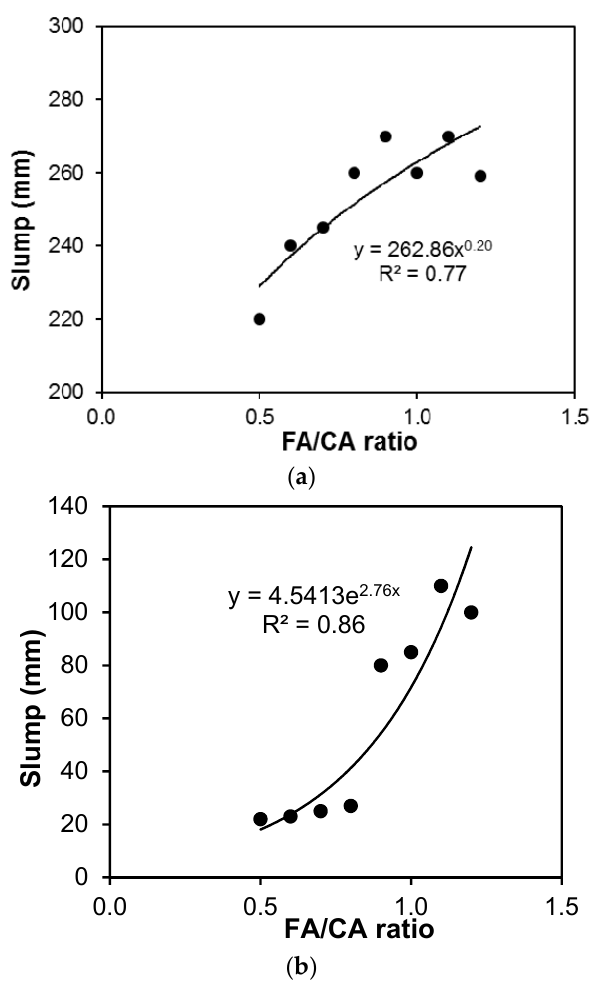
Figure 4. Slump vs. FA / CA ratio for concrete ( a ) slump of concrete without fiber; ( b ) slump of concrete with